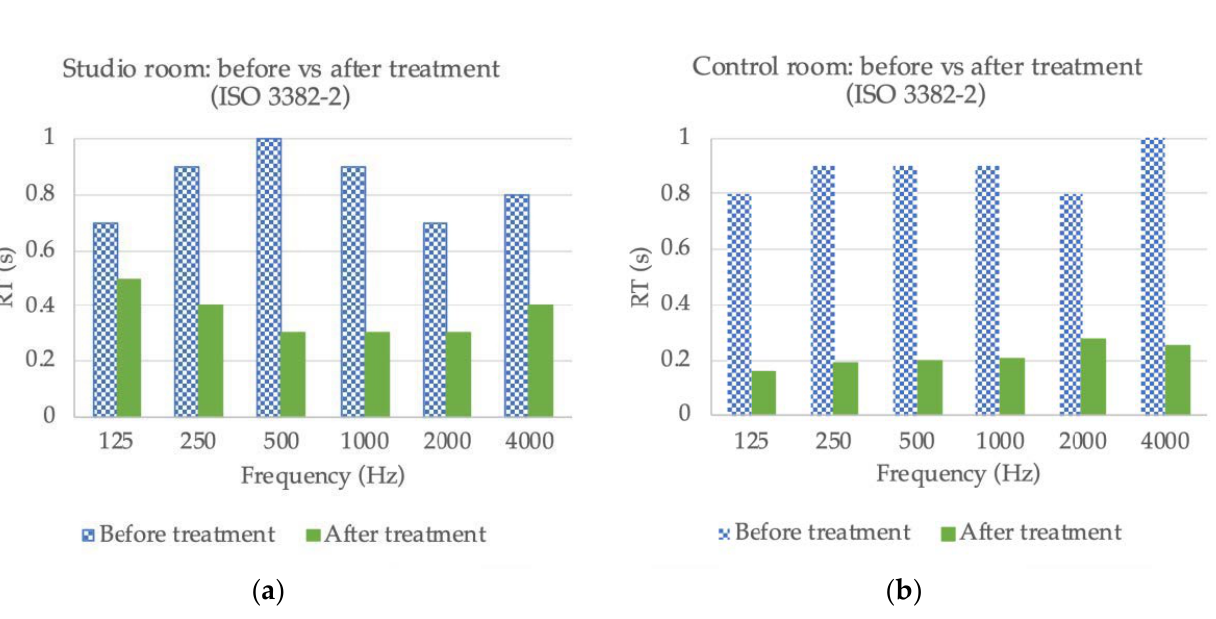
Figure 19. The final reverberation time of the rooms: ( a ) studio room; ( b ) control